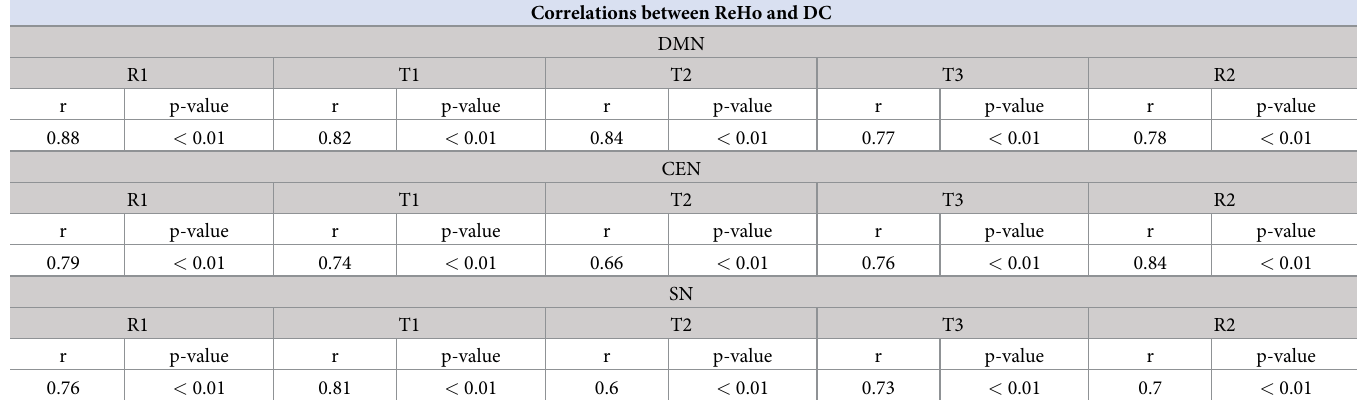
Table 4. The relationships between the fMRI measures (ReHo, and DC) across the brain networks (DMN, CEN, and SN). All correlations coefficients were positive and significant at p < 0.01. Correlations between ReHo and